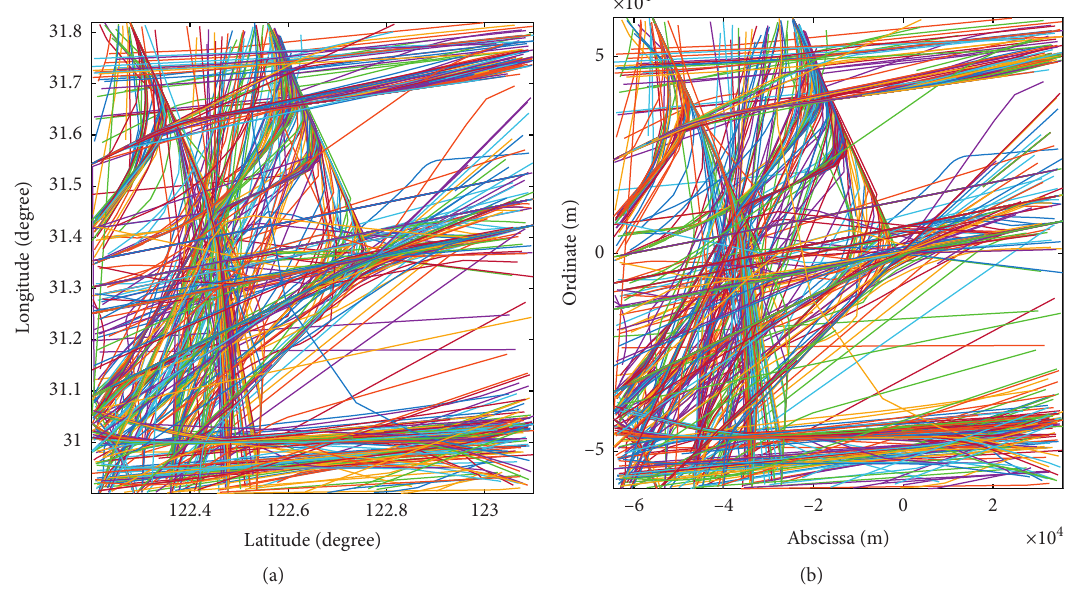
Figure 4: December 14, 2019, 122.2 ° –123.1 ° east longitude, 30.9 ° –31.82 ° north latitude trajectory data. (a) Before processing wrong. (b) After processing wrong.